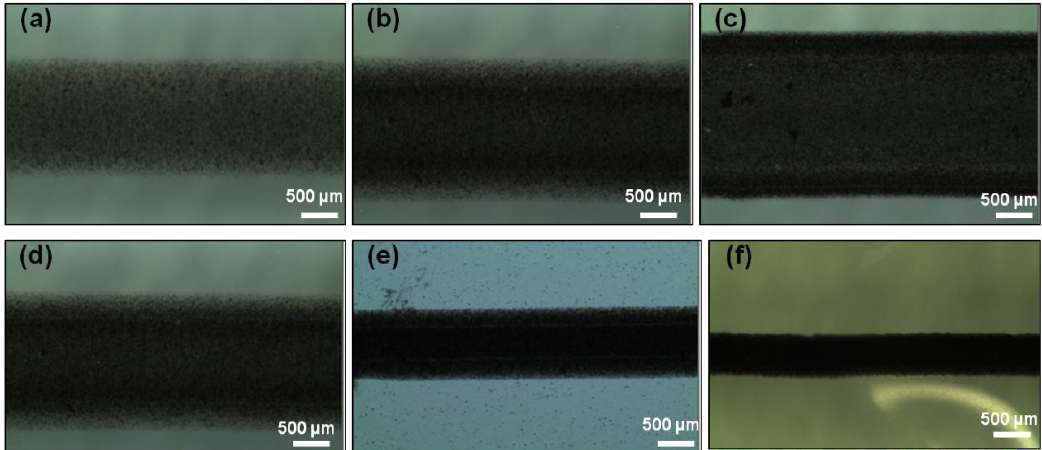
Figure 3. Photographs of IC-MWNT inks: ( a ) In syringe prior to printing; ( b – d ) printed tracks on glass (1, 2 and 3 layers thick), IC (2 layers) and PET (2 layers) substrates, respectively.